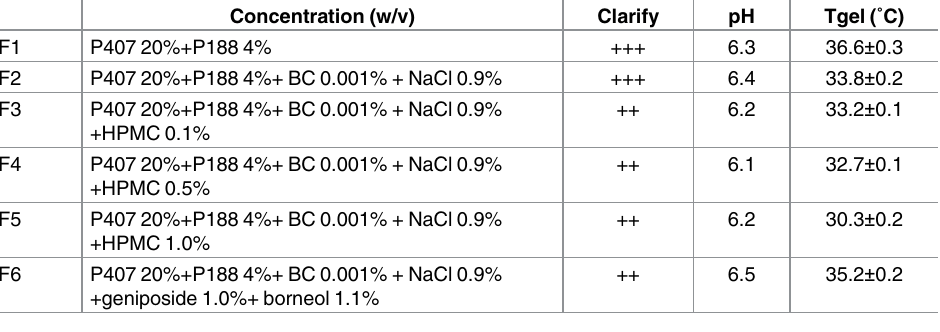
Table 2. Effects of BC, NaCl, HPMC, geniposide and borneol on gelation temperature (n = 3).